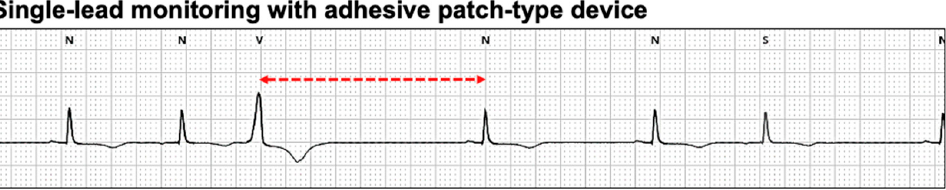
Figure 8. The outlier with different maximum RR intervals between the two devices. Both devices detected the same episode for their detection of the maximum RR interval. However, there was a minute difference in maximum RR intervals (red lines) between both devices (less than 50 ms). We concluded there existed minute differences in detecting R-wave peaks between both